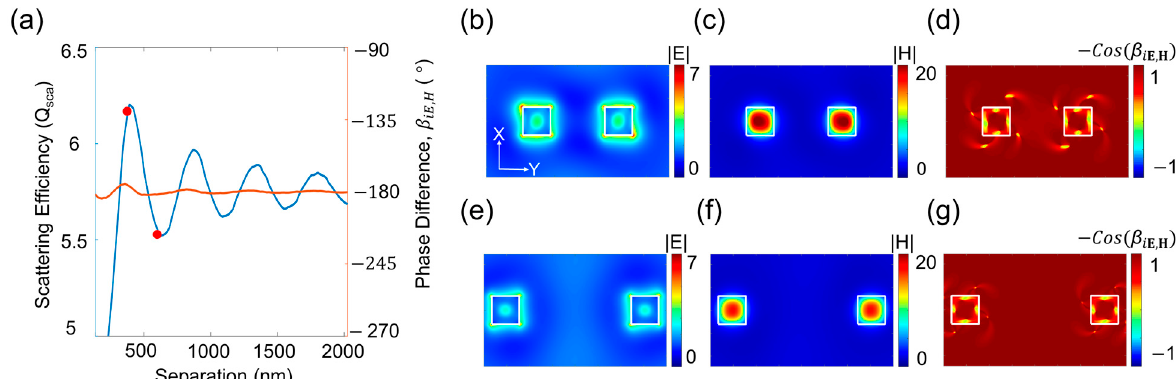
Figure 5. ( a ) The scattering efficiency and phase difference as the separation is tuned. ( b ) The electric field, ( c ) the magnetic field, and ( d ) the profile of cos ( β i E , H ) at the separations of 355 nm ( b–d ) and 610 nm ( e–f ). The peak and dip of scattering efficiency marked as red circles in ( a ).